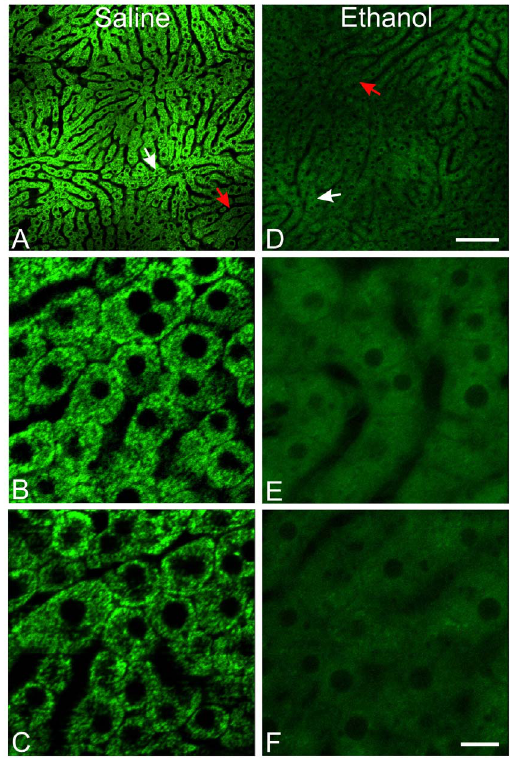
Figure 1. Acute ethanol causes widespread mitochondrial depolarization in the liver. Mice were treated with saline (left column) or ethanol (6 g/kg, i.g ., right column). Intravital multiphoton microscopy of Rh123 was performed after 6 h using a 25 6 water objective lens. A and D , zooming at 0.7 6 . B , C , E and F , zooming at 4 6 . White arrows identify zooming areas shown in B and E . Red arrows identify zooming areas shown in C and F . Darker areas are pericentral regions of the liver lobules. Bar is 100 m m in A and D and 10 m m in B, C, E and F.